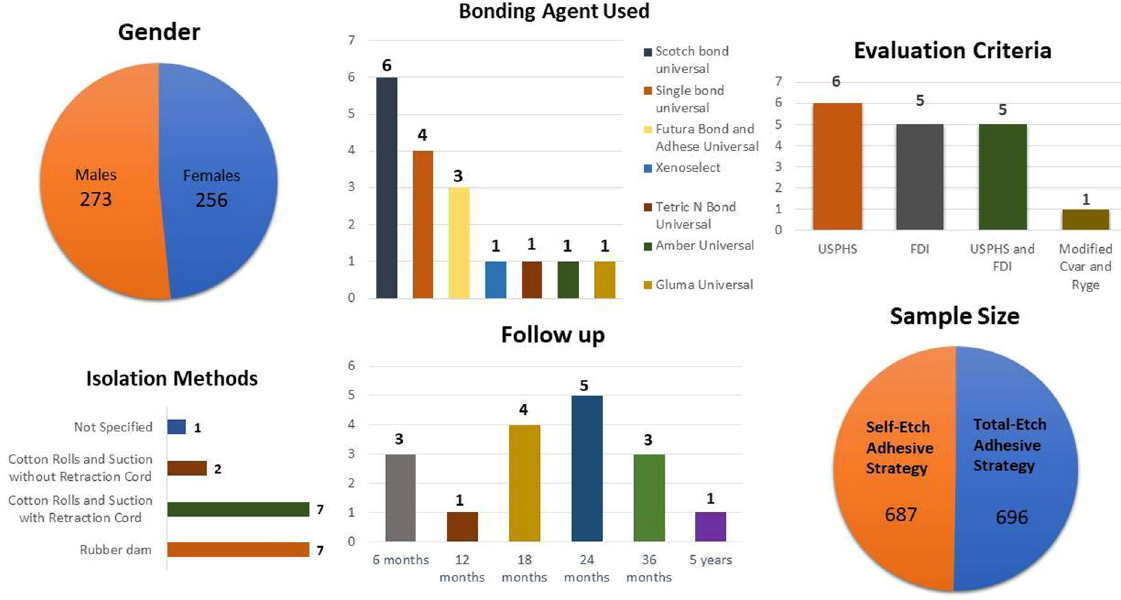
Fig. 2 Risk of Bias Graph. Graph representing each risk of bias item presented as percentages across all included